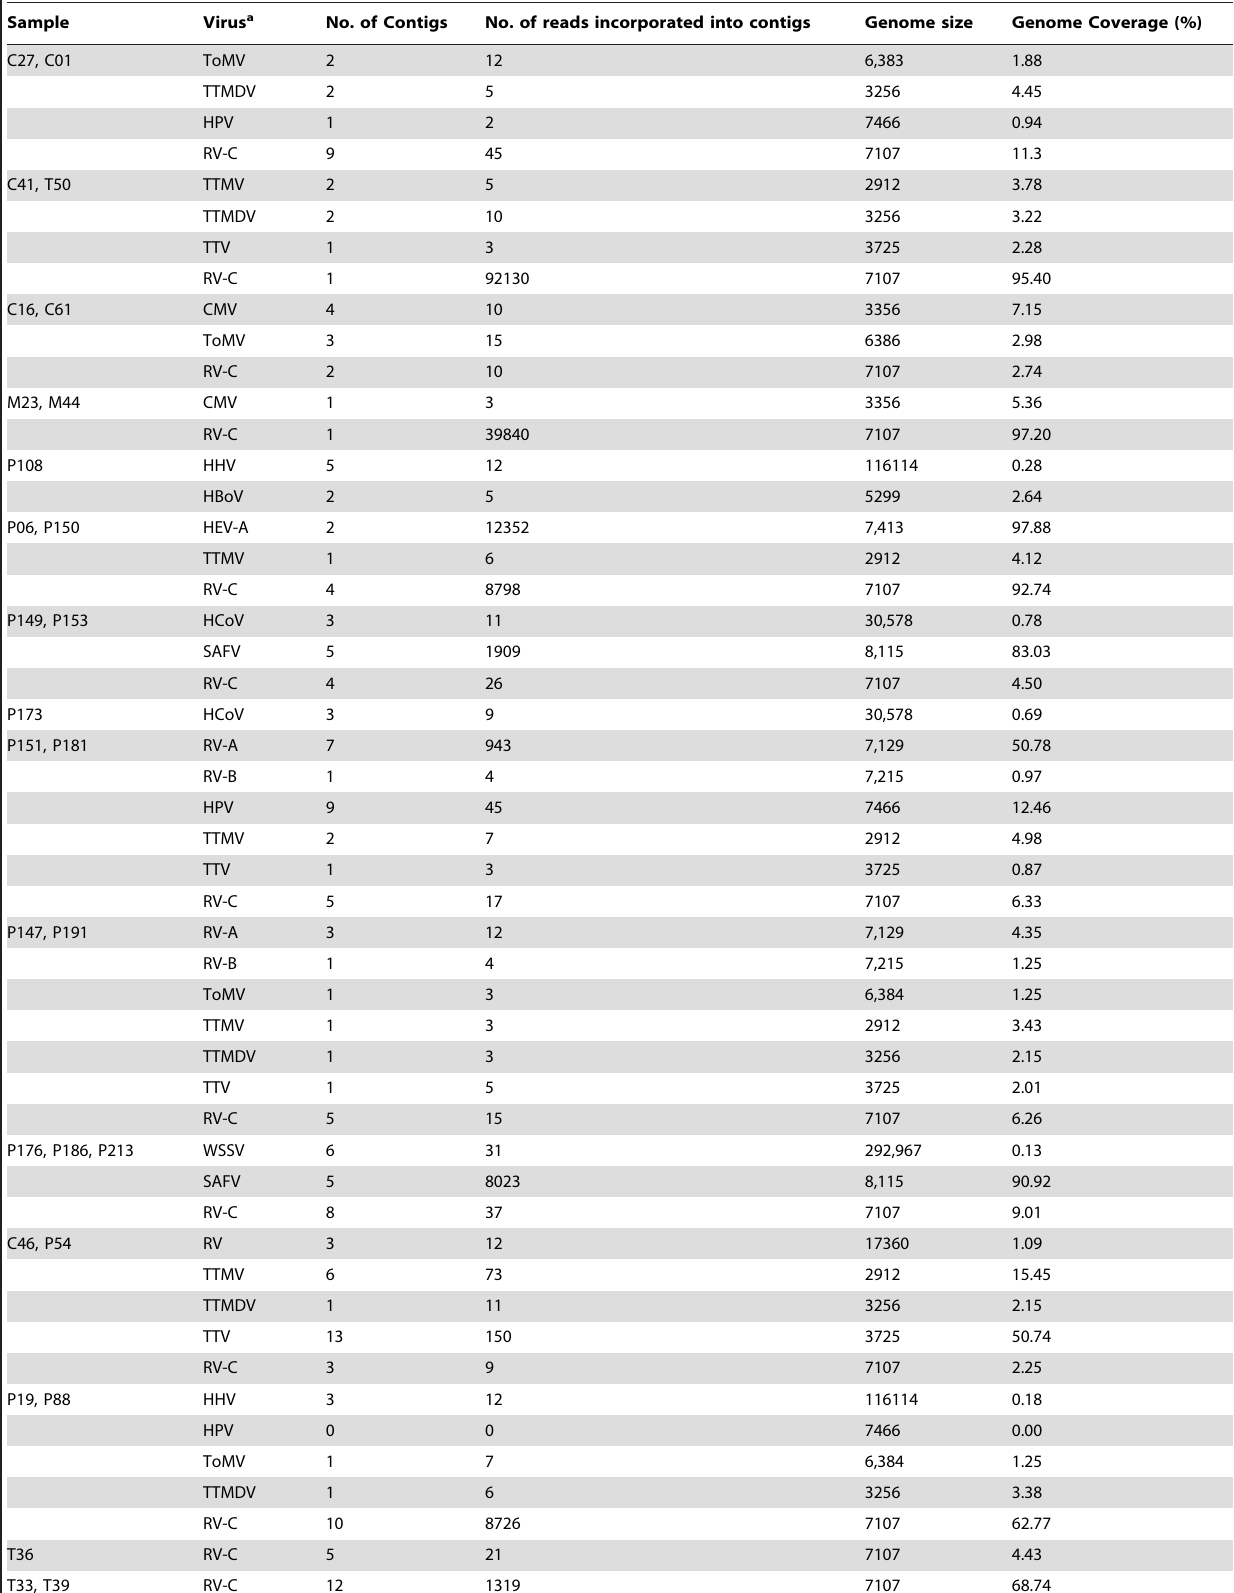
Table 7. Genome coverage for viruses present in URTI samples.